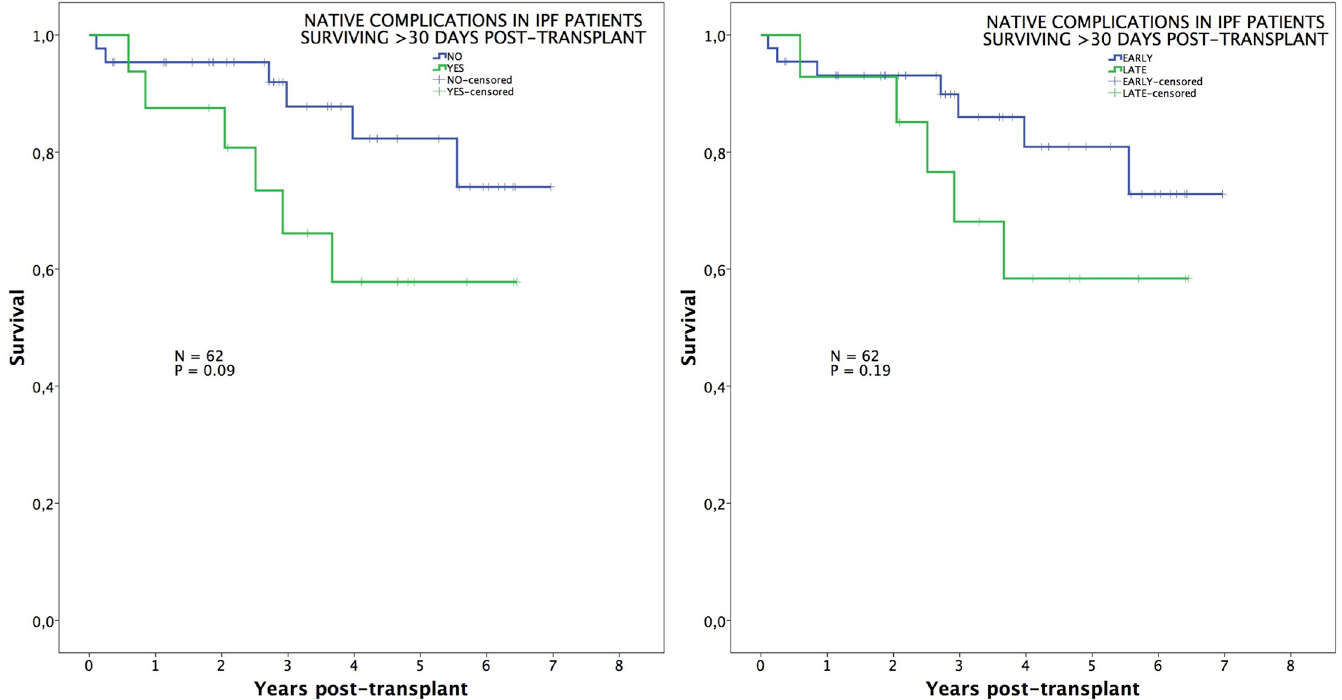
Fig 5. Survival in IPF patients conditional to survive 30 days. Post-transplant survival, conditional to survive 30 days, of IPF patients comparing those with or without native lung complications (left), and those with early or late native lung complications (right).